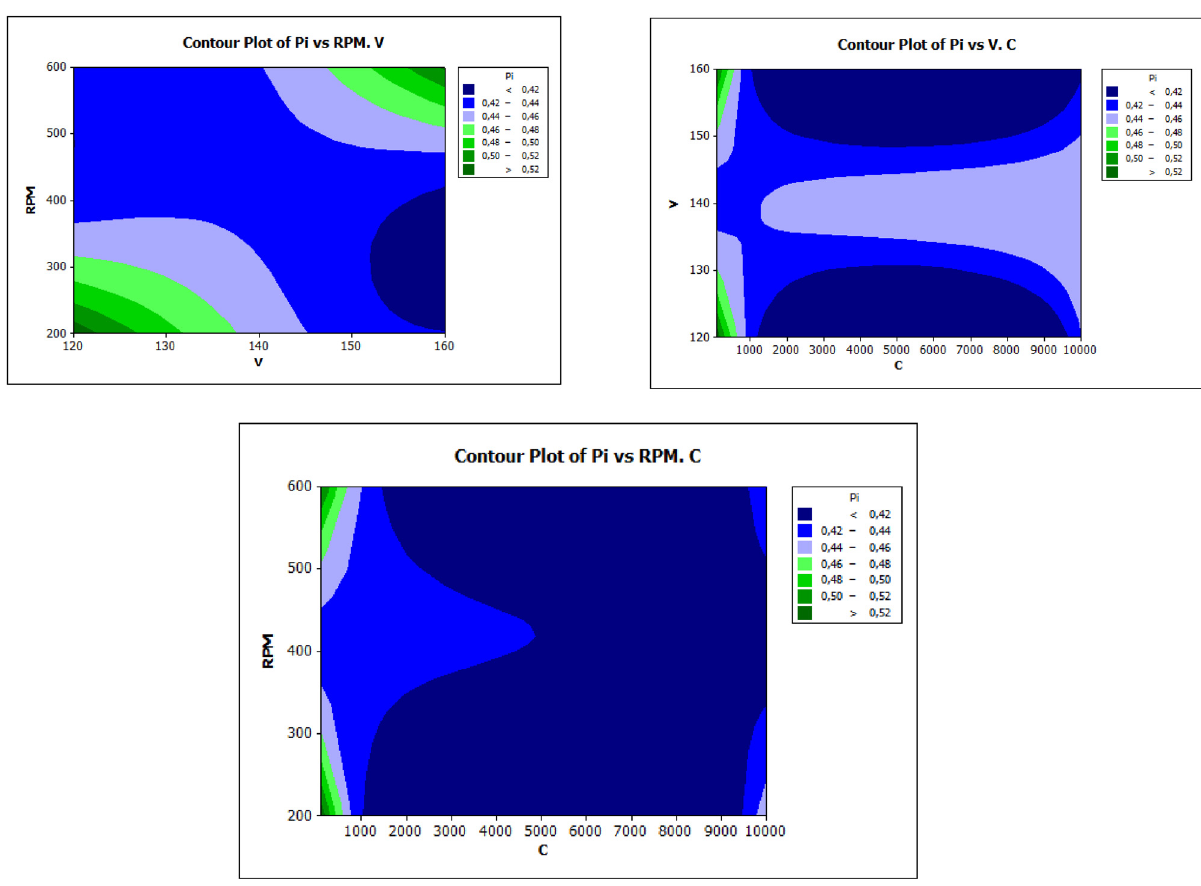
Figure 6: Contour plots for P i in Deng ’ s method.